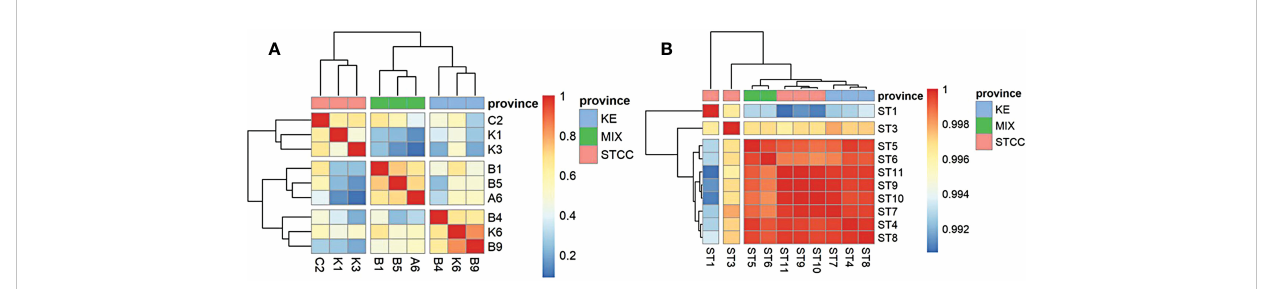
FIGURE 3 Correlation heat map analysis between two sampling cruises based on the relative abundance calculation of the top 20 species. (A) the genus level data of spring cruise in 2015. (B) the species level data of summer cruise in 2018. Pink represents STCC (Subtropical countercurrent), Blue represents KE (Kuroshio extension countercurrent), and green represents MIX (the Kuroshio-Oyashio mixing